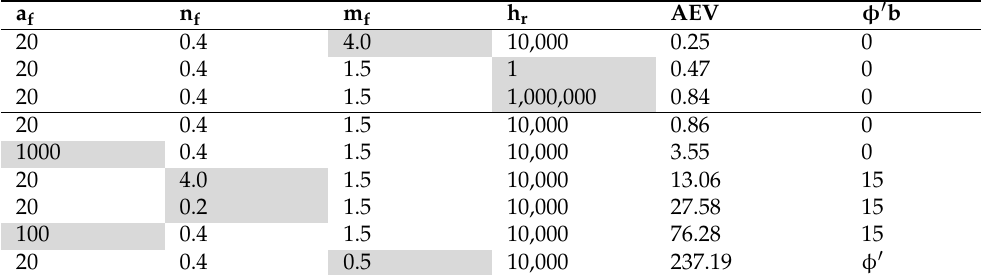
Table 3. Air entry values for different Fredlund and Xing fitting parameter